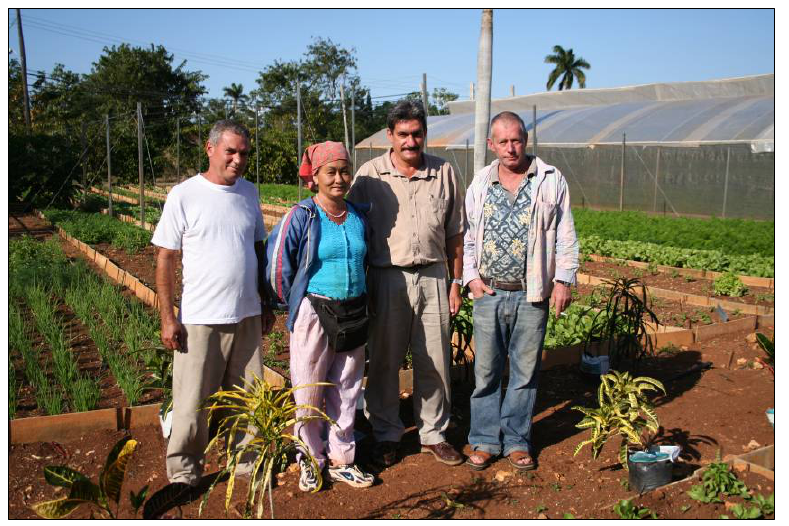
Figure 3. Parcela gardeners in Havana’s La Coronela neighborhood.